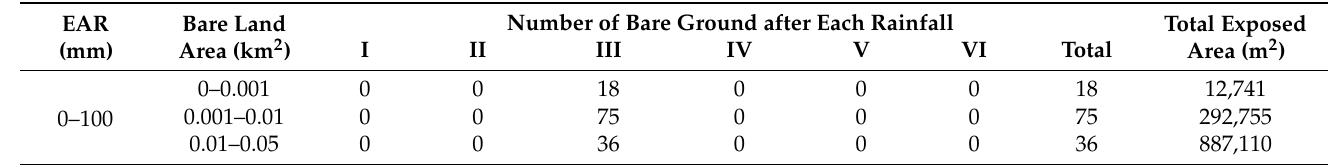
Table 7. Number of bare lands and bare land area after each rainfall in the study